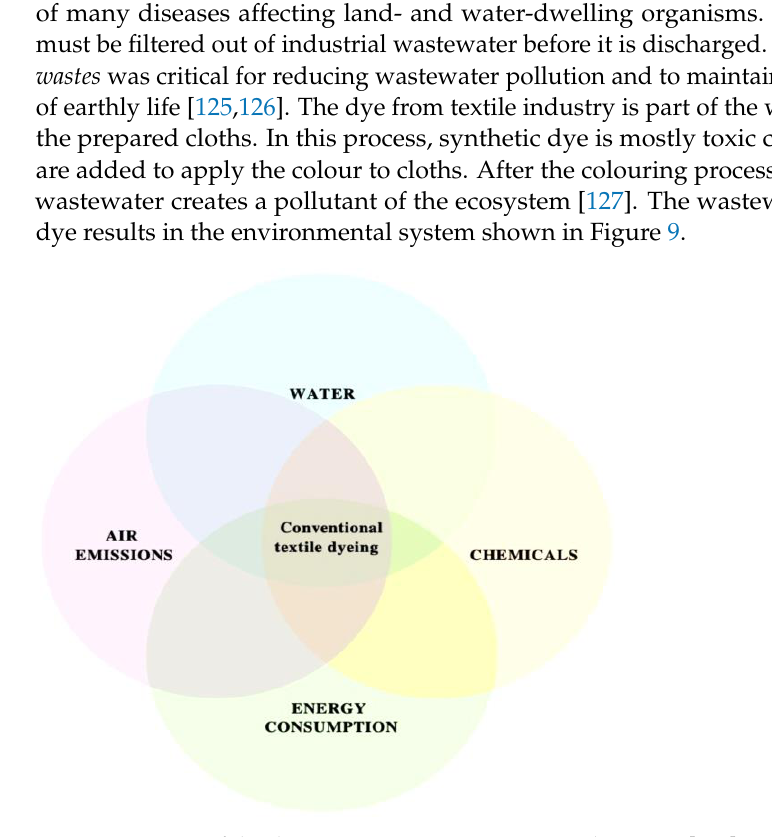
Figure 9. Impact of the dyeing process on environmental systems